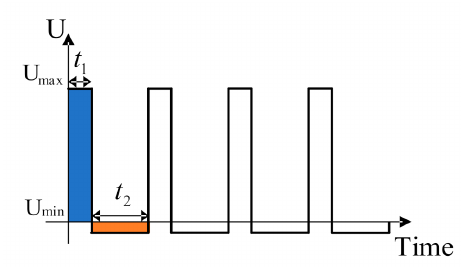
Figure 3. The High field asymmetric voltage waveform diagram.